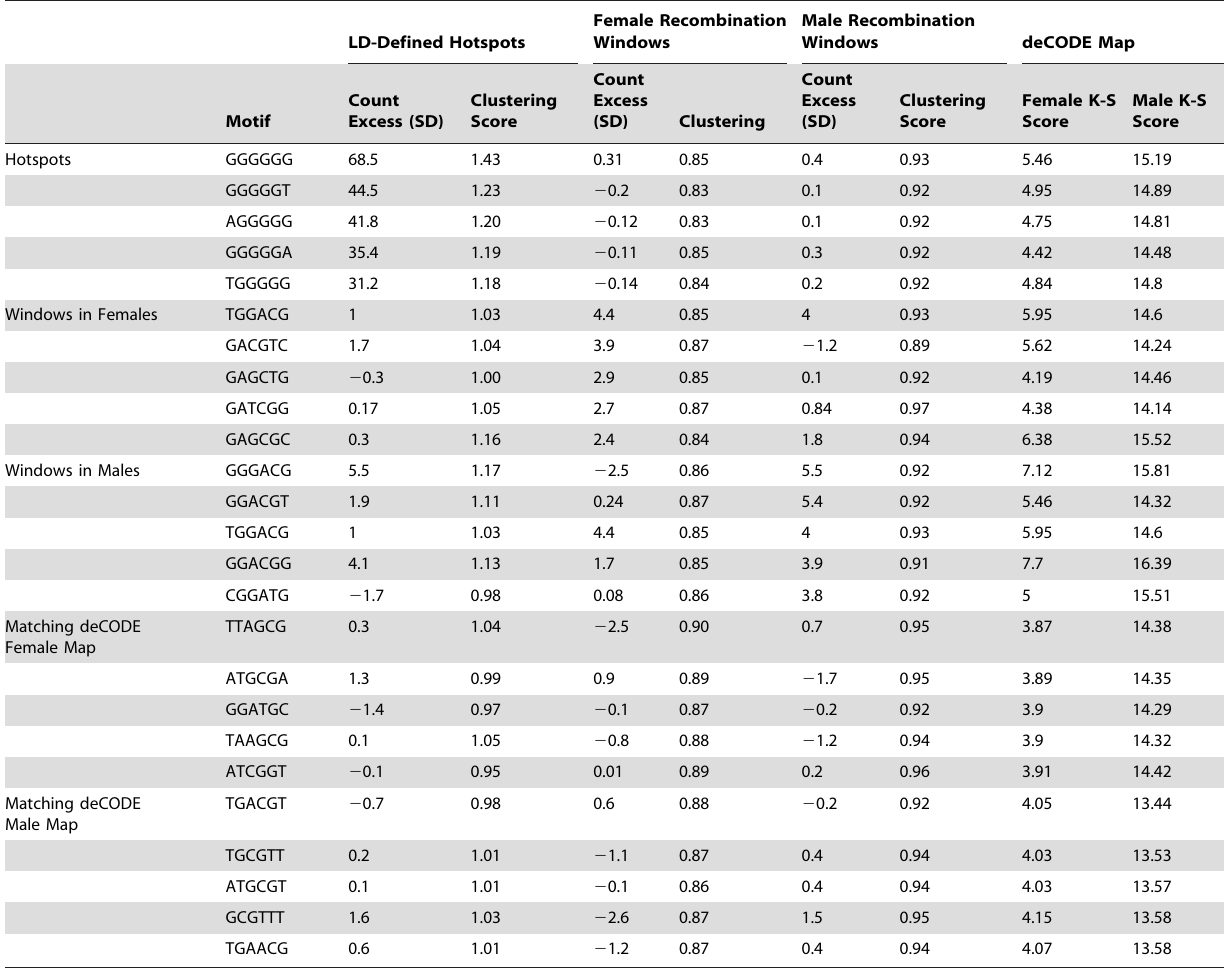
Table 2. 6-mer Motif